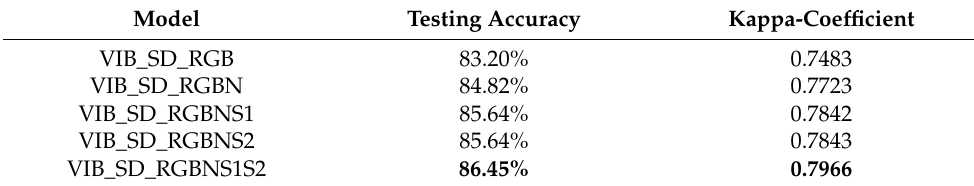
Table 9. Performance of models using variant bands with the same